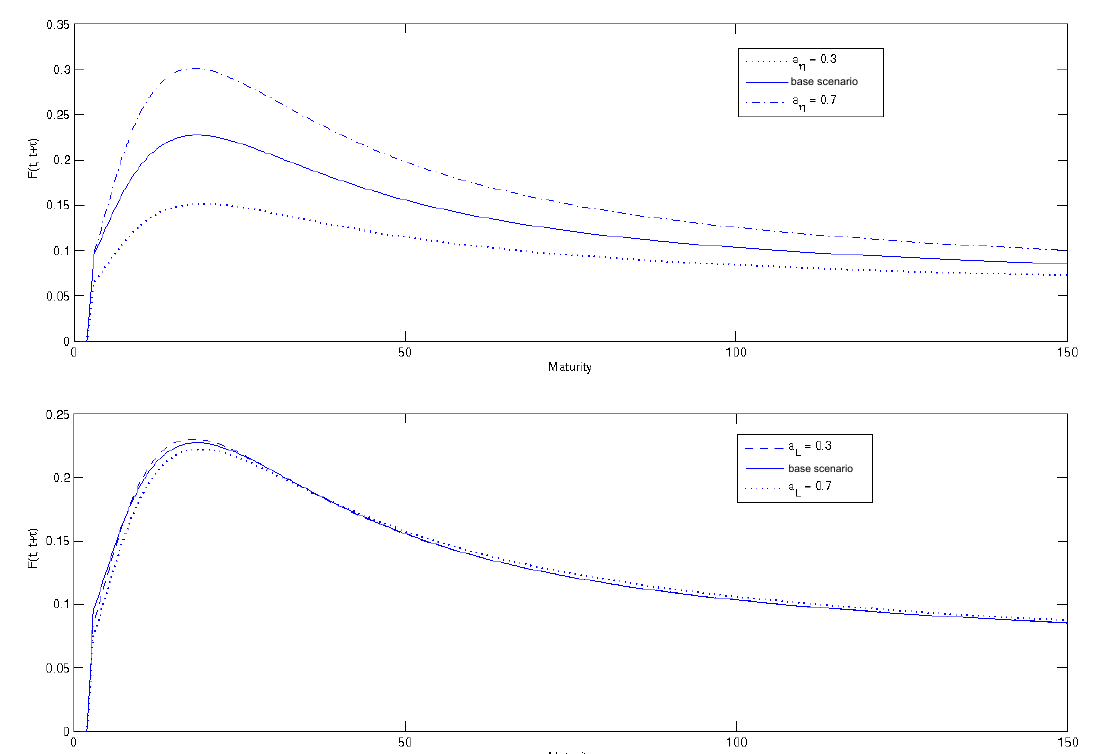
Figure 18. Forward yield for different degrees of uncertainty perceived by economic